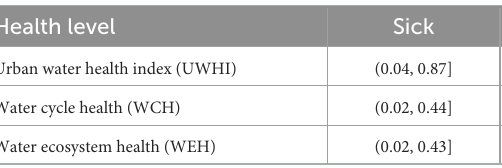
TABLE 4 Thresholds for each level.